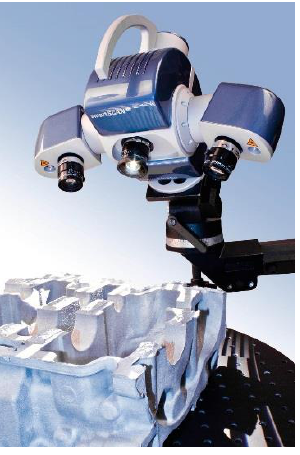
Figure 20: Scanning of a crankcase